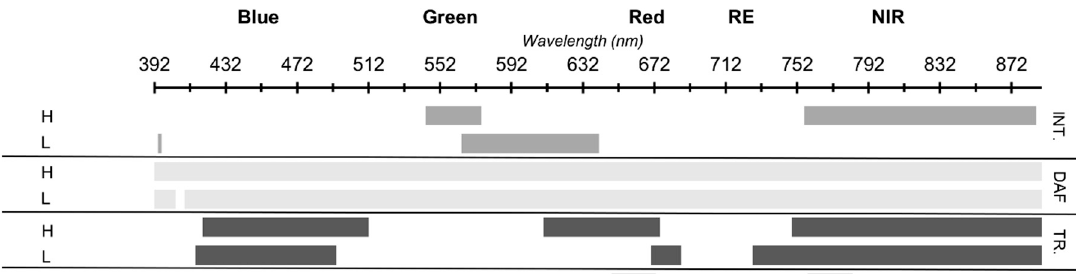
Figure 5. Summary of bands with significant p values ( p ≤ 0.05) for the interaction (INT.) and main effect of the frost treatment (TR.) and days after frost (DAF) for heads (H) and leaves (L).